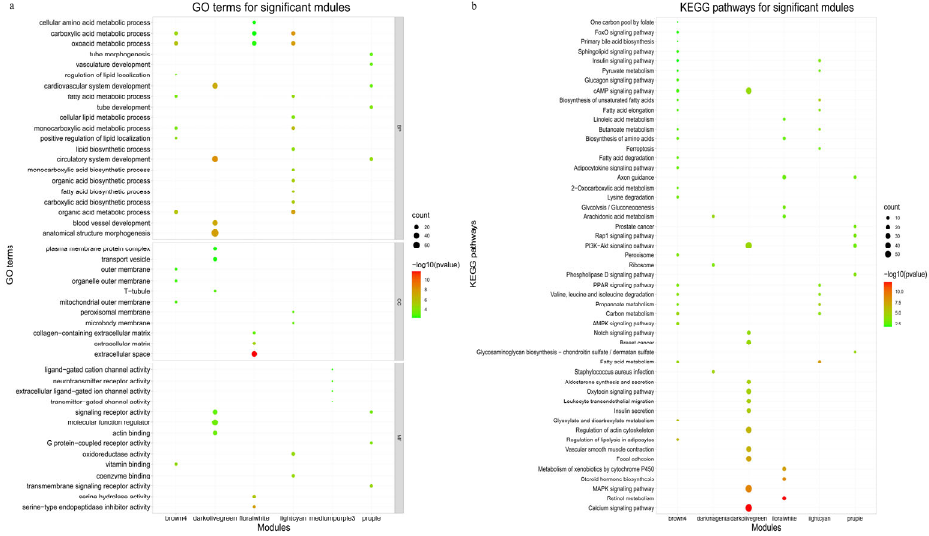
Figure 6. GO annotation ( a ) and KEGG pathway ( b ) of genes enriched in significant modules. Table 2. Hub genes associated with the fat deposit in the lightcyan module.